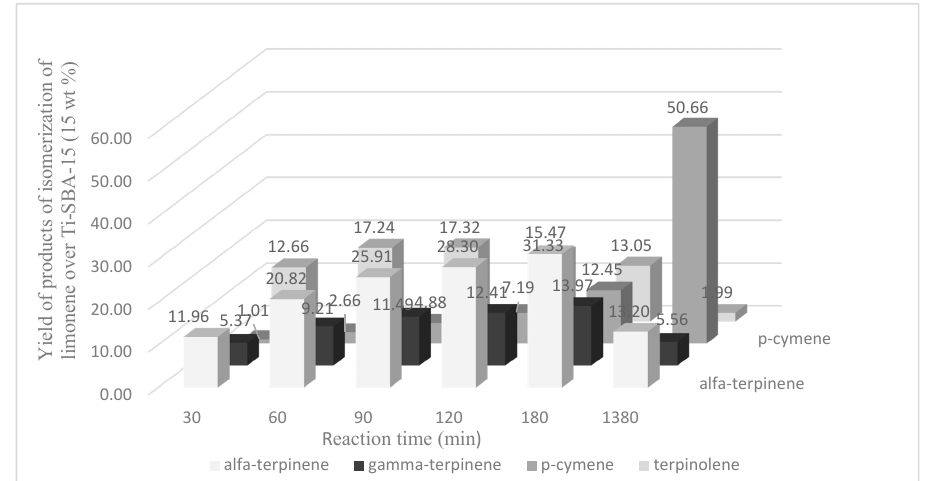
Figure 3. The influence of the reaction time on the yields of products of isomerization of limonene. Amount of the catalyst was 0.75 g (15 wt % in relation to the mass of limonene), temperature was 160 °C, and reaction time was 30, 60, 90, 120, 180, or 1380 min. The best results were obtained for the catalyst Ti-SBA-15 content of 15 wt % and at the temperature of 160 °C. Under these conditions, the conversion of limonene was close to 90 mol % after a reaction time of 180 min and after a reaction time of 1380 min almost all limonene underwent transformation. At a lower process temperature (150 °C), limonene conversion after the reaction time of 1380 min was below 90 mol % (88.83 mol %), the same as for 140 °C, at which the conversion amounted to 73.86 mol % (Figure 4). The results show that at the highest content of the catalyst the